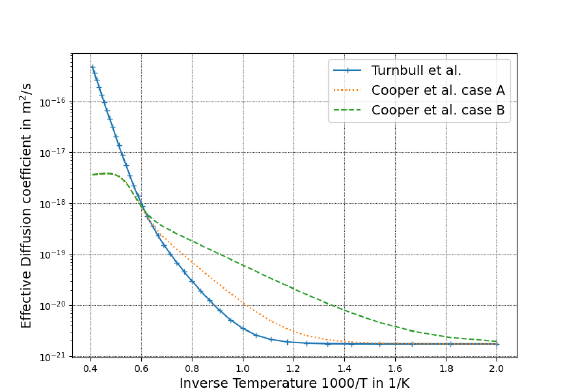
Figure 2. Gas diffusivity in undoped UO Turnbull et al. model, and gas diffusivity in Cr-doped UO 2 fuel applying Cooper et al.